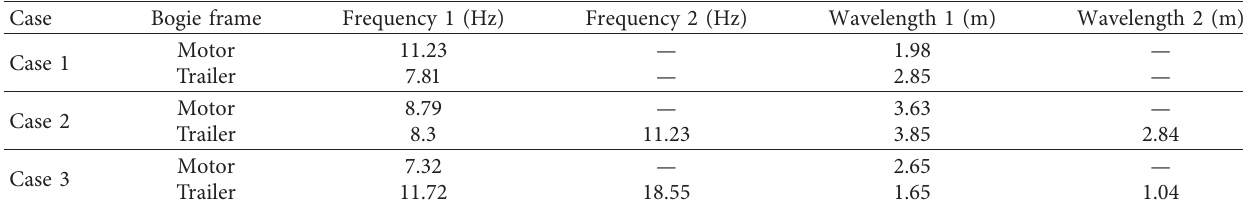
Table 5: Characteristic